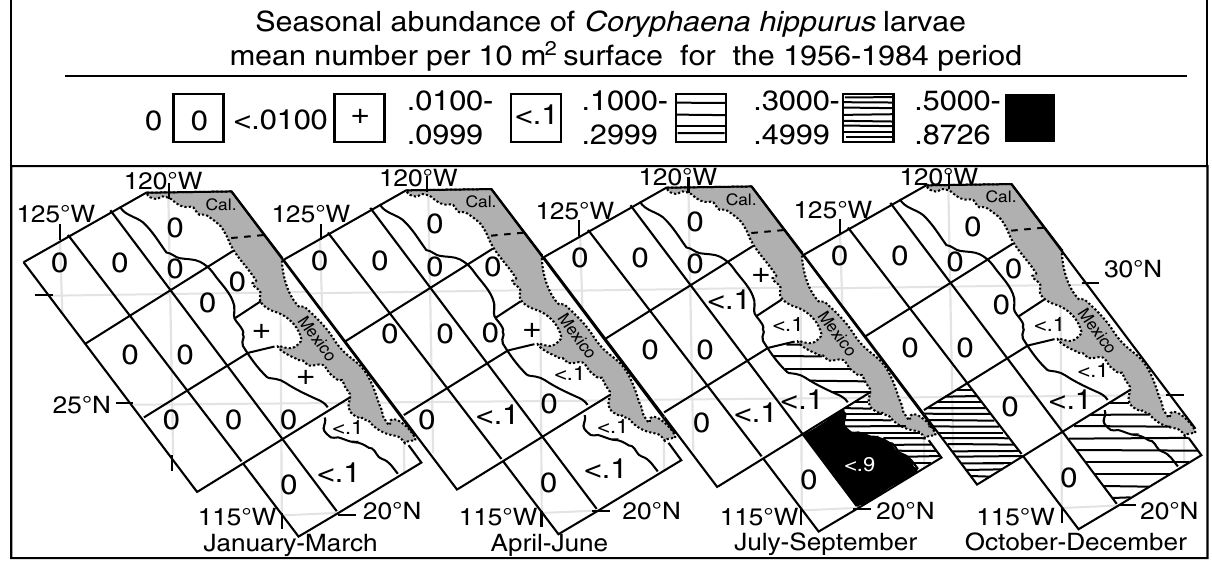
F IG . 3. – California Cooperative Oceanic Fisheries Investigations (CalCOFI) sampling of seasonal distribution of dolphinfish larvae off south- ern California and northern Mexico. Symbols show abundance (number per 10 m 2 ) in each area in each season averaged over 29 years. Fewer than 1000 total larvae were found in the 29-year period. Redrawn from Moser et al.,